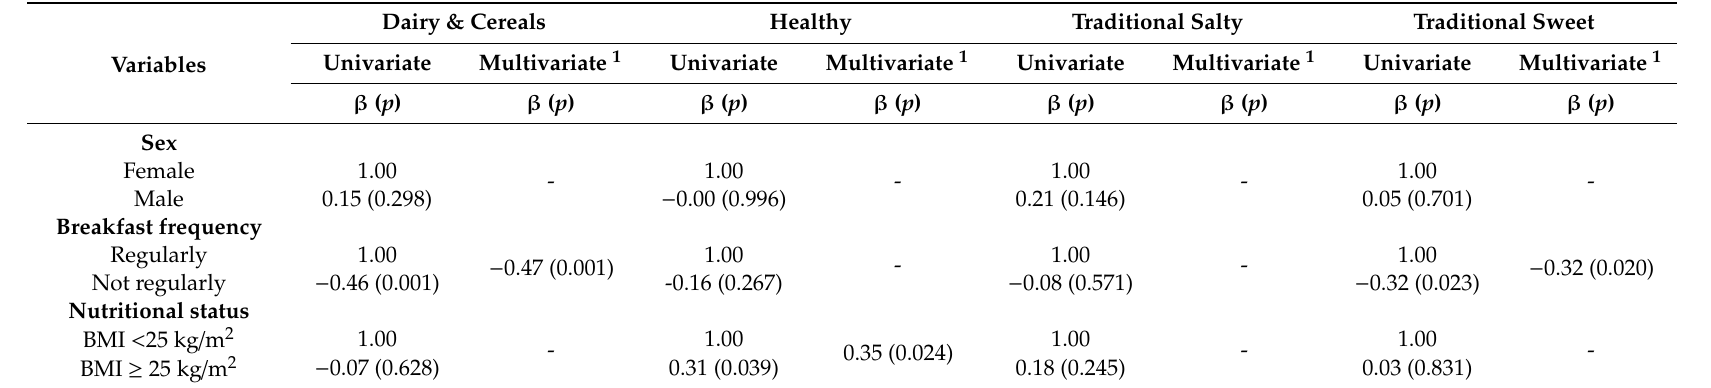
Table 4. Associations among dietary patterns scores and characteristics of Chilean university students. Dairy & Cereals Healthy Traditional Salty Traditional Sweet Univariate Multivariate 1 Univariate Multivariate 1 Univariate Multivariate 1 Univariate Multivariate